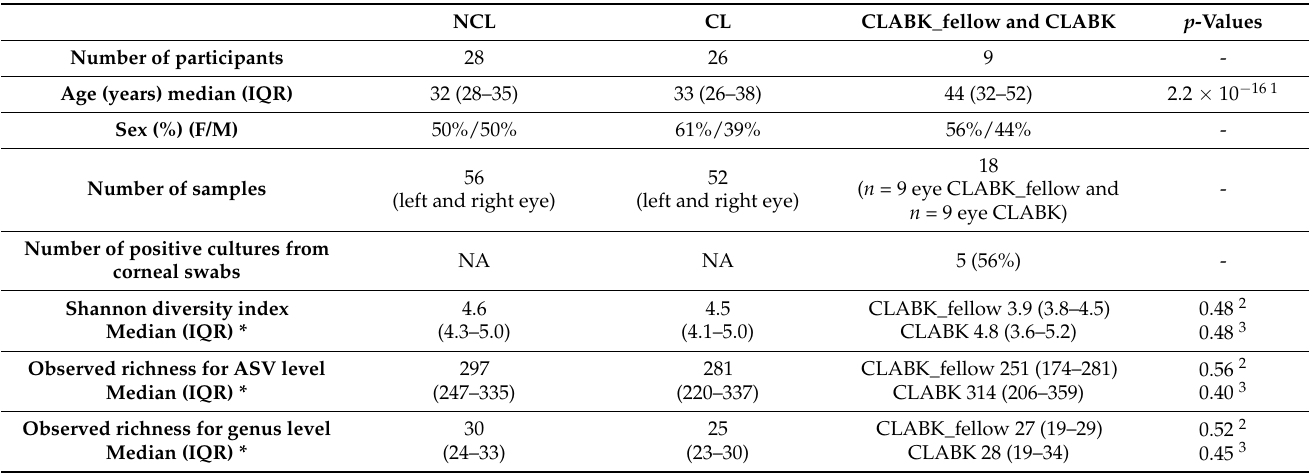
Table 1. Overview of the study population and alpha diversity analysis results with Shannon diversity index and observed richness. NCL—non-contact-lens users. CL—contact lens users. CLABK_fellow = eye without contact-lens-associated bacterial keratitis; CLABK = eye with contact-lens-associated bacterial keratitis: IQR—Interquartile range; ASV—amplicon sequence